Question: How would you classify this visualization?
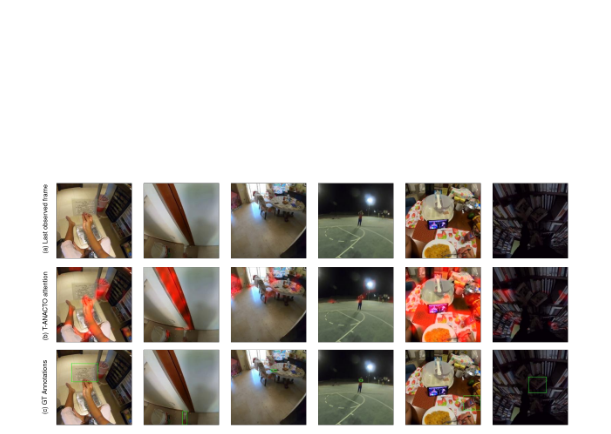
Answer: scatter